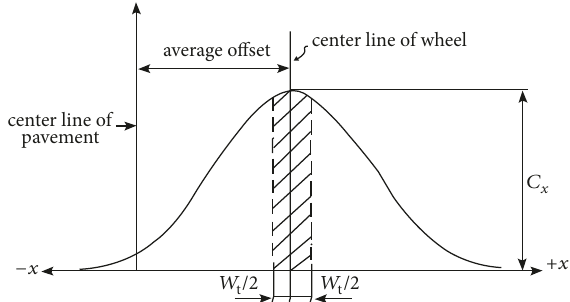
Figure 3: Schematic representation of pass-to-coverage ratio calcu- lation.